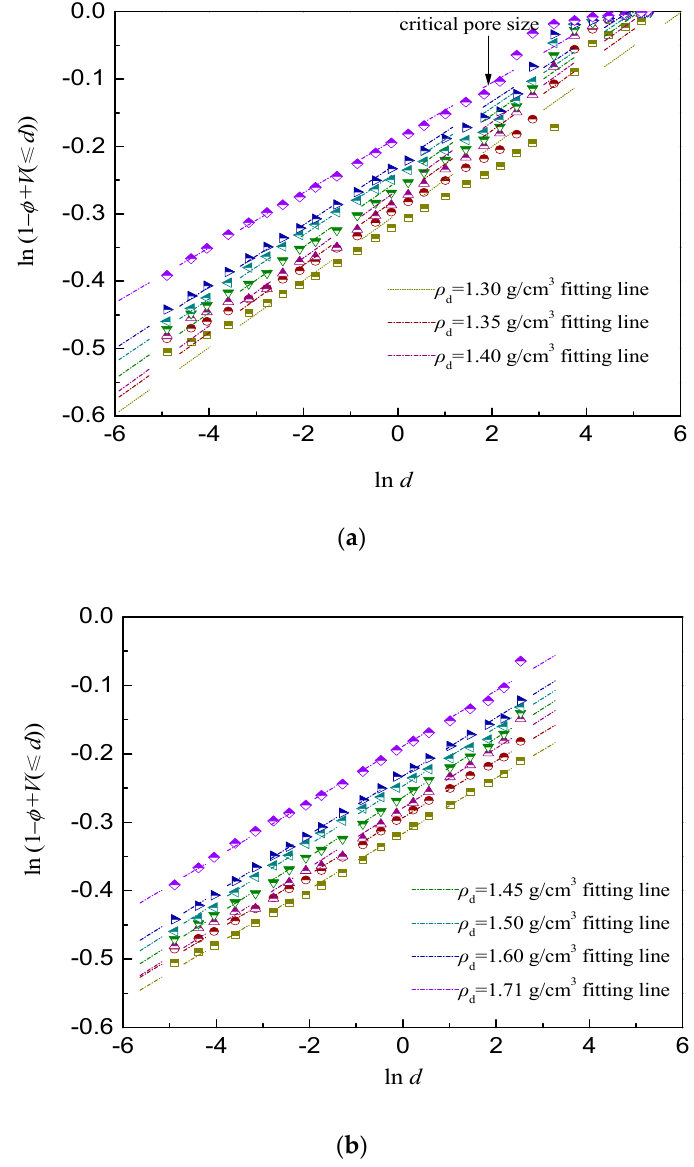
Figure 6. Determination of fractal dimension D. ( a ) neglecting “critical pore size”; ( b ) considering “critical pore size”. Table 1. Fitting results of fractal dimension corresponding to Figure 6a.